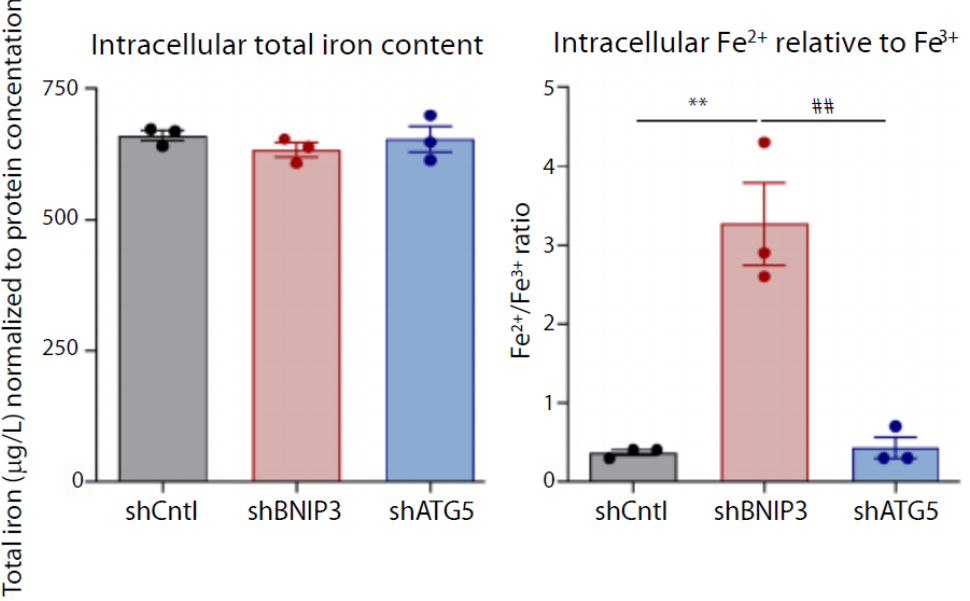
Figure 3. Intracellular total iron content ( left ) and Fe 2+/ Fe 3+ ratios ( right ), measured by CE-ICP-DRC-MS in normoxic B16-F10 cells (n = 3). The data are analyzed using a one-way ANOVA with Tukey’s multiple comparisons test. ** p < 0.01 shBNIP3 compared against shCntl, ## p < 0.01 shBNIP3 compared against shATG5.Reprinted, [76]. Copy right year: 2021, copyright owner: John Wiley and Sons.